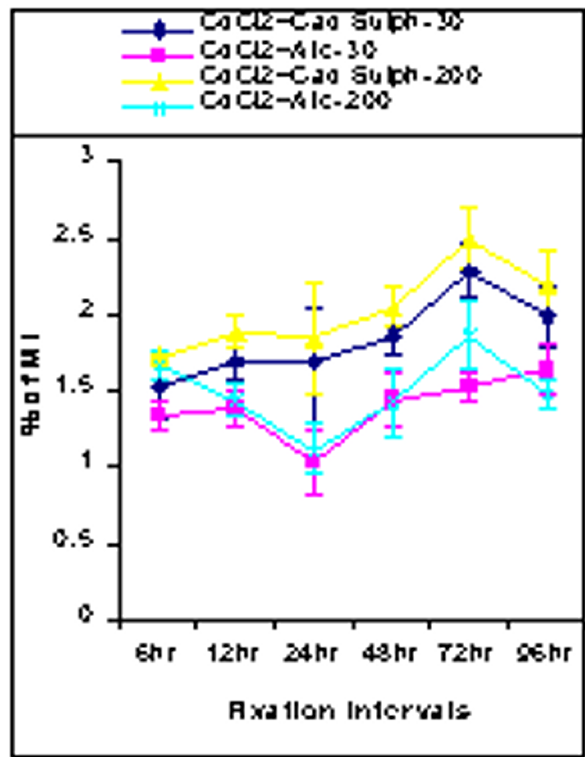
Figure 3 Showing time-dependent frequencies of Cad Sulph-30 pre- fed and Cad Sulph-200 pre-fed series versus their respective CdCl 2 treated alcohol-30 and alcohol-200 control